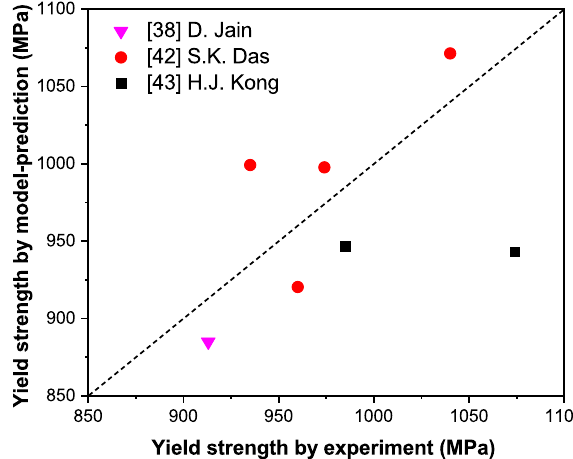
Fig. 3 Comparison of the yield strength by model prediction and the experiments. The model-predicted value is equal to the experimental value if the symbol is located on the dashed diagonal